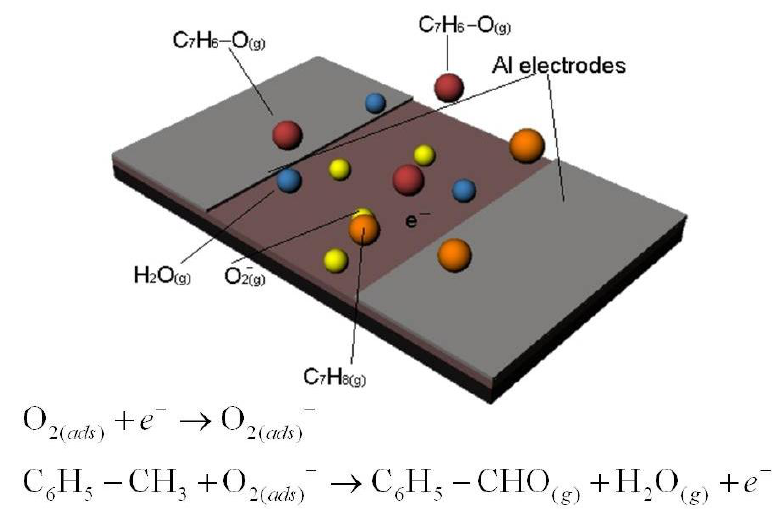
Figure 5. Toluene sensing mechanism.